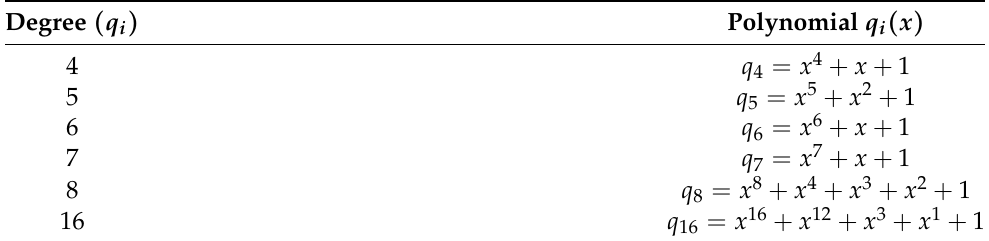
Table 3. List of primitive polynomial used for the extended field